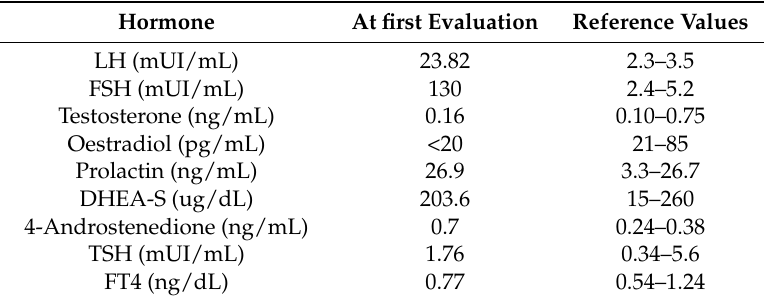
Table 1. Serum hormone concentrations in Patient 1 at diagnosis. Hormone At first Evaluation Reference